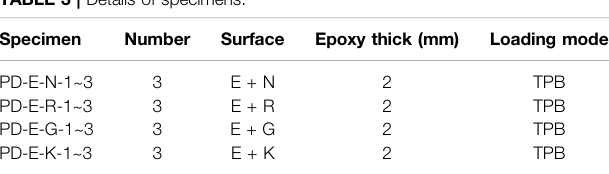
TABLE 3 | Details of